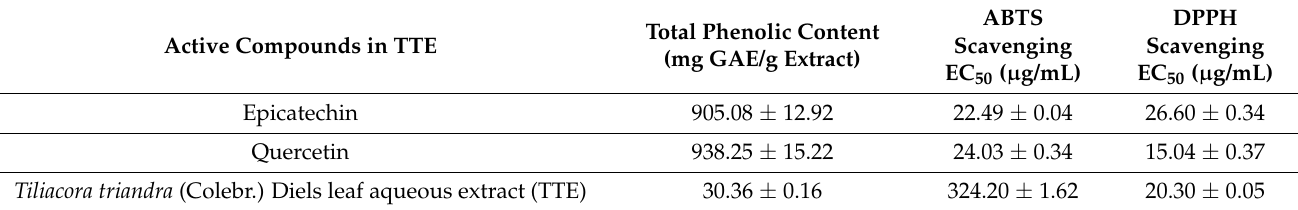
Table 2. Total phenolic contents and radical scavenging activities of TTE and its major